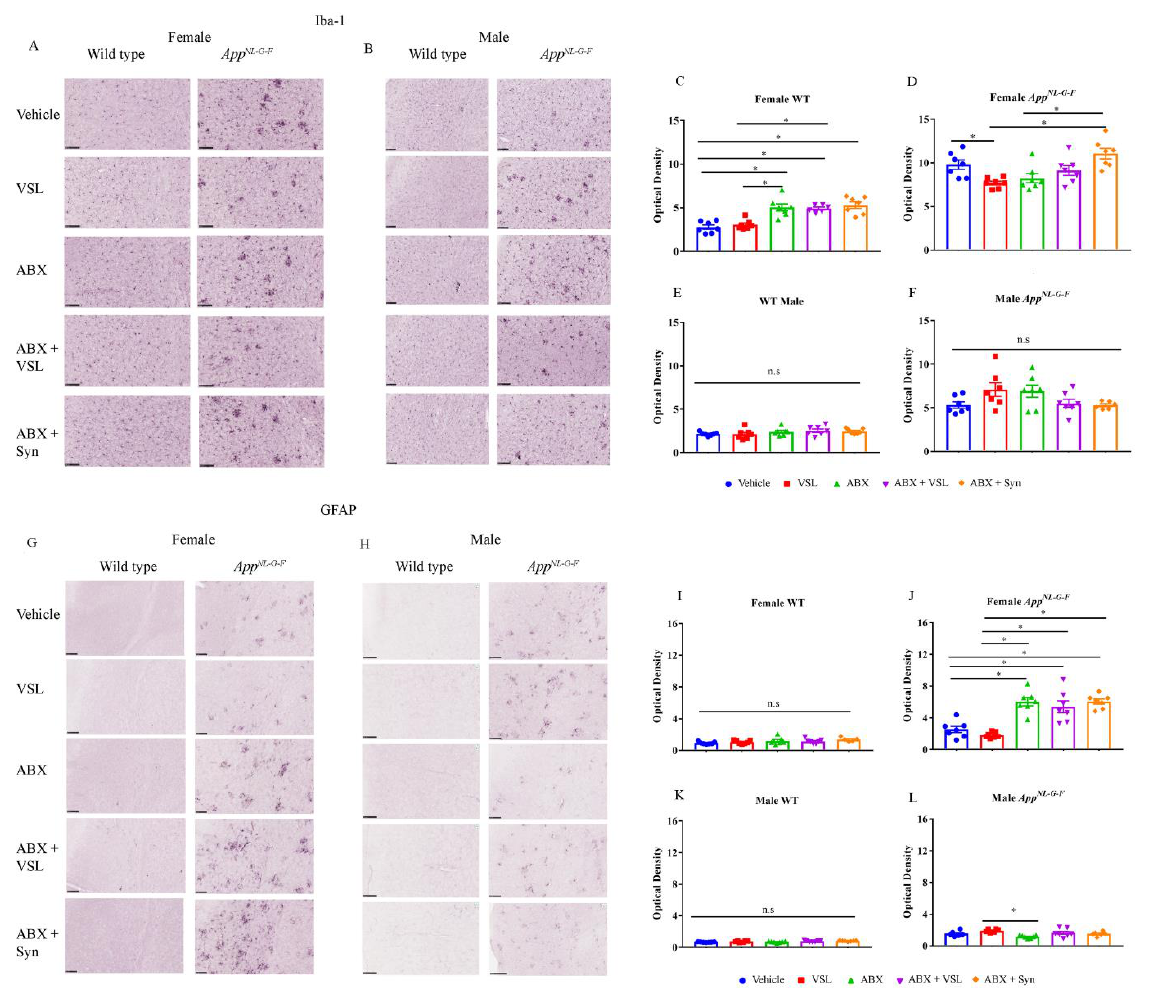
Figure 3. Effect of probiotic and antibiotics treatments on Iba1 and GFAP immunoreactivity. Representative immunohisto- chemical staining images for ( A , B ) Iba1 and ( G , H ) GFAP from temporal cortices of female and male WT and App NL-G-F mice treated with vehicle, VSL#3, antibiotics (ABX), antibiotics+VSL#3 (ABX + VSL), and antibiotics+VSL#3+prebiotic (ABX+Syn) are shown. Quantitation of ( C – F ) Iba1 and ( I – L ) GFAP immunostaining was performed from two sections from each animal, and optical density values were averaged and presented as mean ± SEM. Significant differences were determined by a one-way analysis of variance, * p < 0.05 ( n = 7). Scale bars are 50 µ m (20 ×